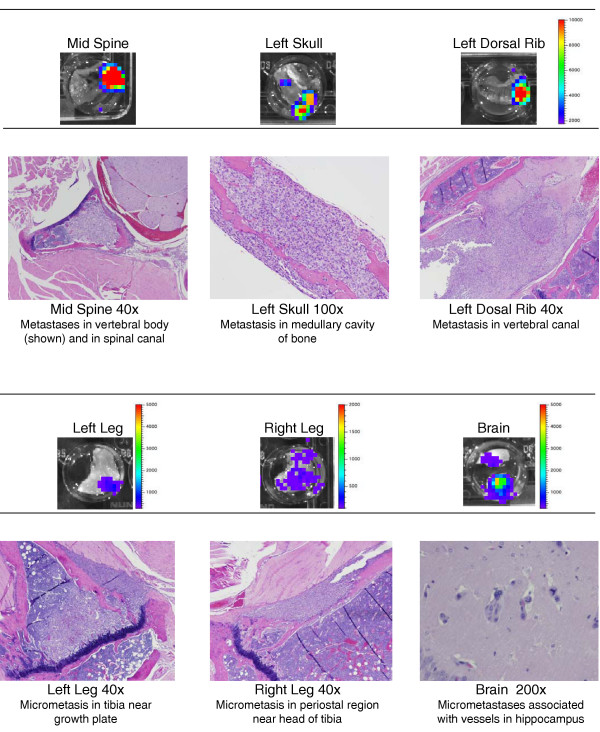
Ex vivo and histological data confirm metastases from intracardiac injection of D3H2LN cells. Representative data from selected tissues from two mice that were evaluated by both ex vivo imaging and subsequent histological analysis are shown.